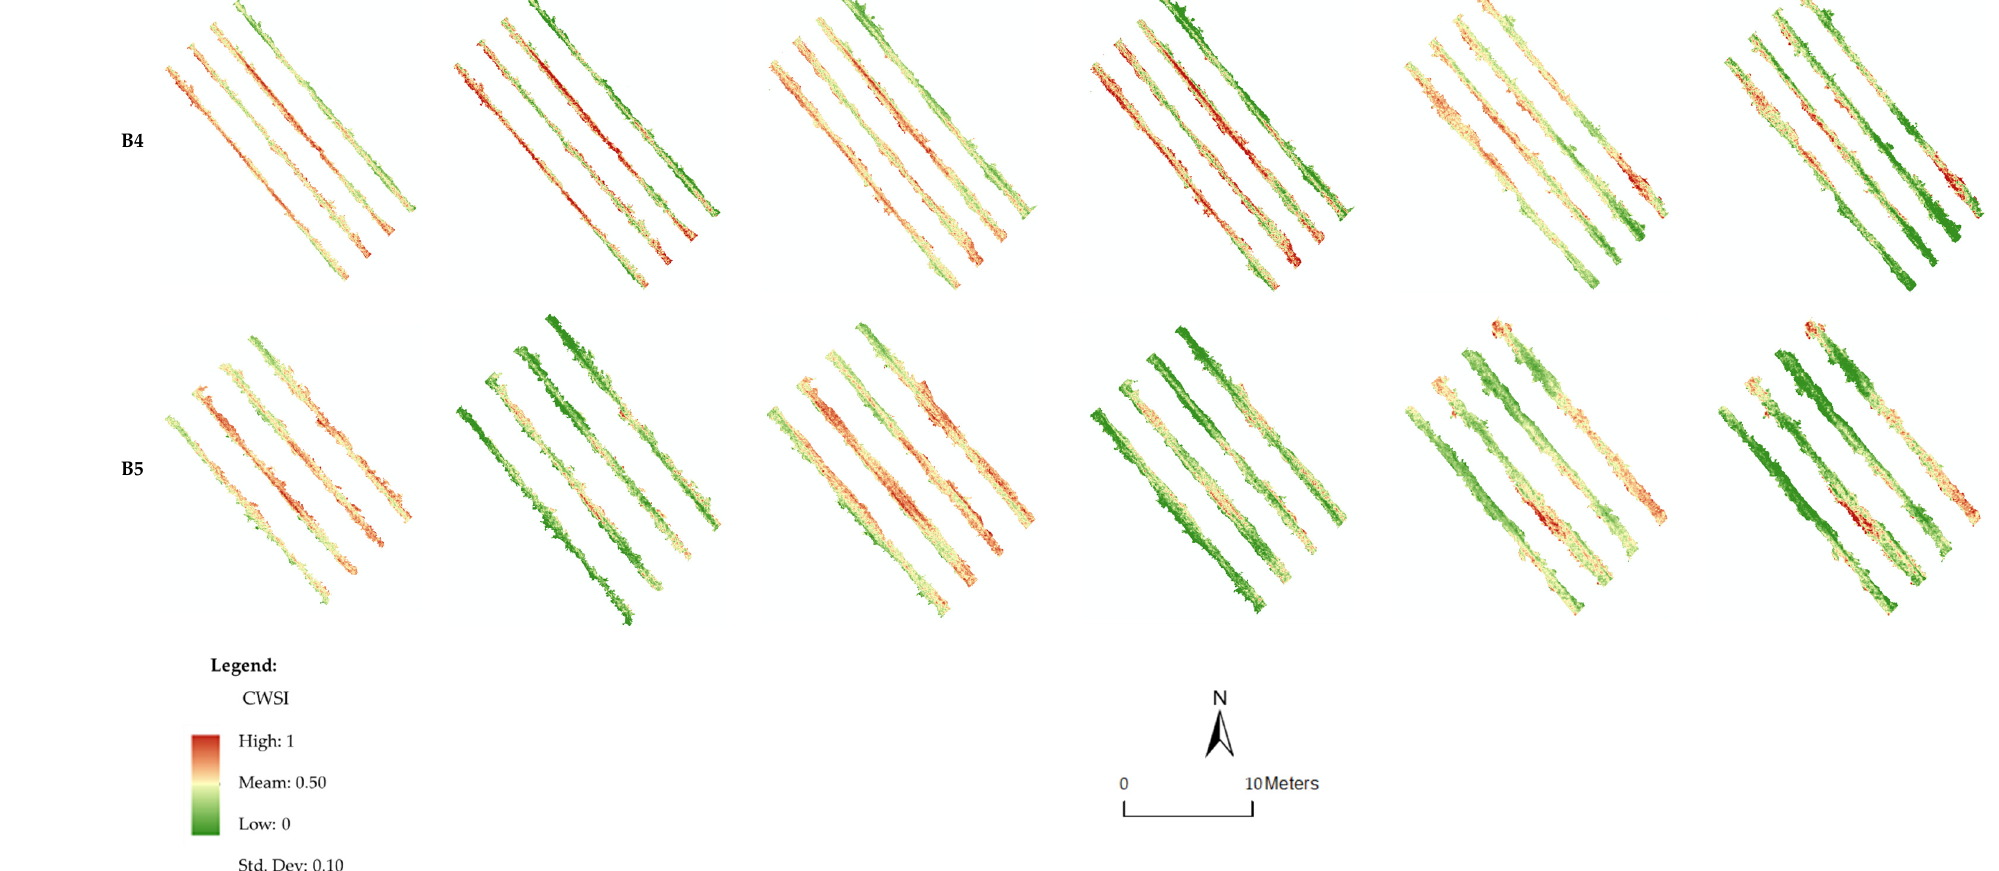
Figure 5. Maps of the five blocks of the CWSI S and CWSI Tair by DOY.